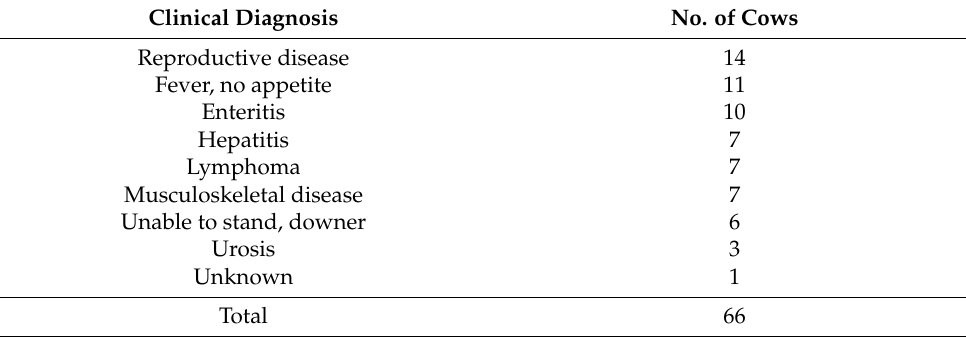
Table 1. Number of the diseased cows in the present study based on the clinical diagnoses by the veterinarians. Clinical Diagnosis No. of Cows Reproductive disease 14 Fever, no appetite 11 Enteritis 10 Hepatitis 7 Lymphoma 7 Musculoskeletal disease 7 Unable to stand, downer 6 Urosis 3 Unknown 1 Total